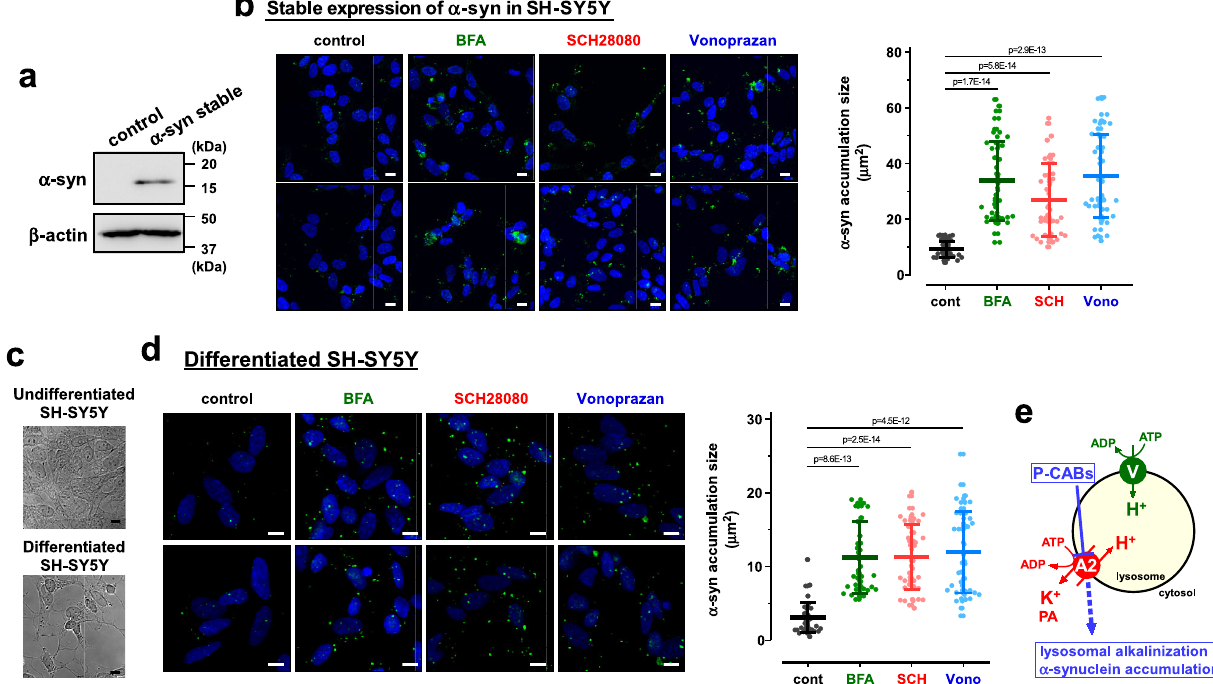
Fig. 5 | Phosphorylated α -synuclein accumulation in the undifferentiated SH- SY5Y cells stably expressing α -synuclein and differentiated SH-SY5Y